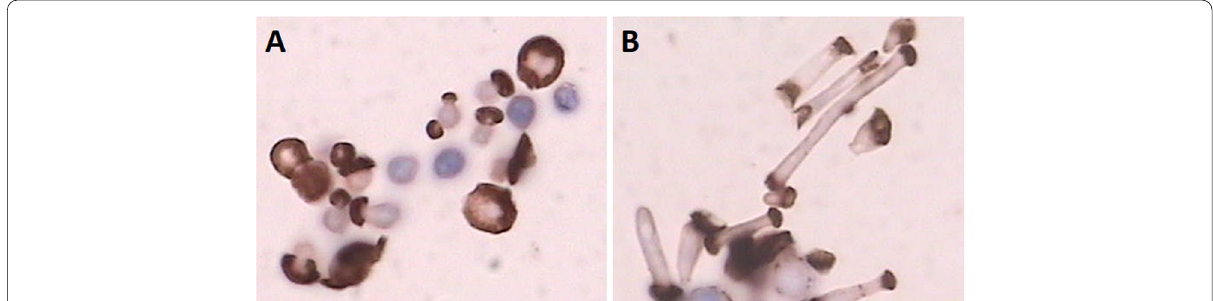
Fig. 3 Immunohistochemical analysis of Candida albicans SC5314 blastospores ( A ) and hyphae ( B ) by 10H8 (